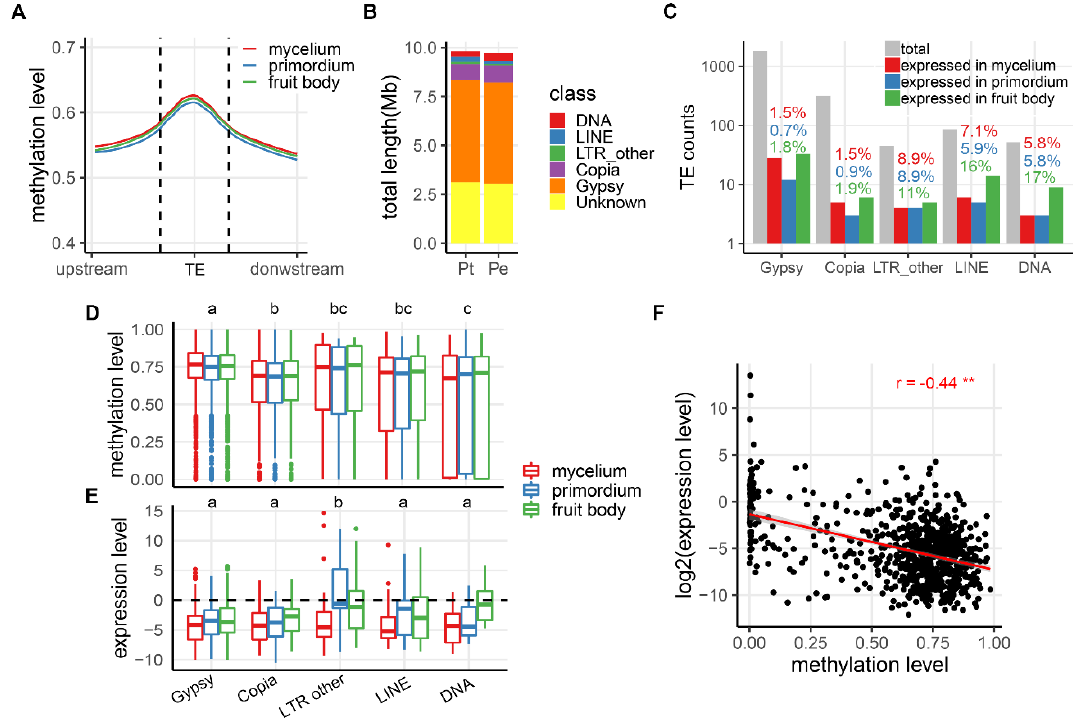
Figure 3. mCG and expression levels in transposable elements (TEs) of Pleurotus tuoliensis (Pt). ( A ) Meta-plots of mycelium (MY, red), primordium (PR, blue) and fruit body (FB, green) mCG levels in TEs. ( B ) Distribution and relative proportion of di ff erent classes of TEs. ( C ) Number of TEs in each class (grey bars) and number of expressed TEs (TPM > 1) in the MY, PR and FB stages. Percentages above the bars showing proportions of expressed TEs in each class. ( D , E ) mCG levels ( D ) and expression levels ( E ) for each class of TEs in the M, P and F stages. The dashed line in ( E ) indicates the static expression trend. The letters above the boxes denote results of Post Hoc Multiple Comparisons among the di ff erent developmental stages, wherein di ff erent letters denote statistical significance. Only TEs with a TPM value > 0 are shown in ( E ). ( F ) Negative correlation between mCGs and expression of TEs. Only TEs with a TPM value > 0 are tabulated. Very similar profiles were obtained for Pe, shown in Figure S4.